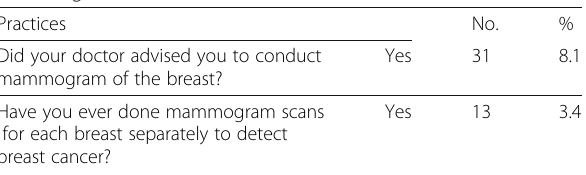
Table 5 Practices of participating women towards breast cancer screening